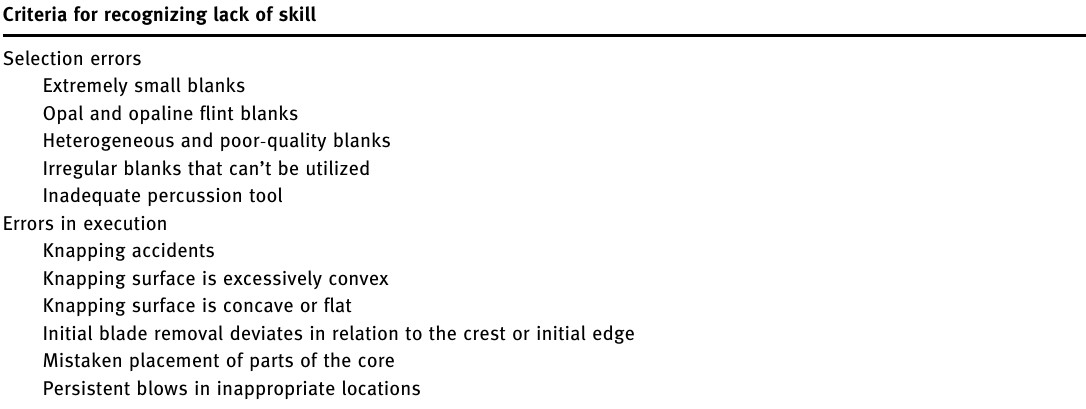
Table 1: Criteria used to classify cores by the presence/absence of mistakes ( Castañeda, 2018, p. 722, Table 1 )